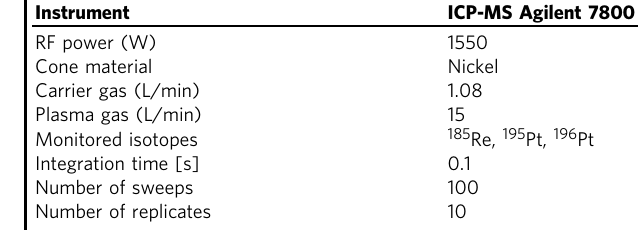
Table 2 ICP-MS measurement parameters.